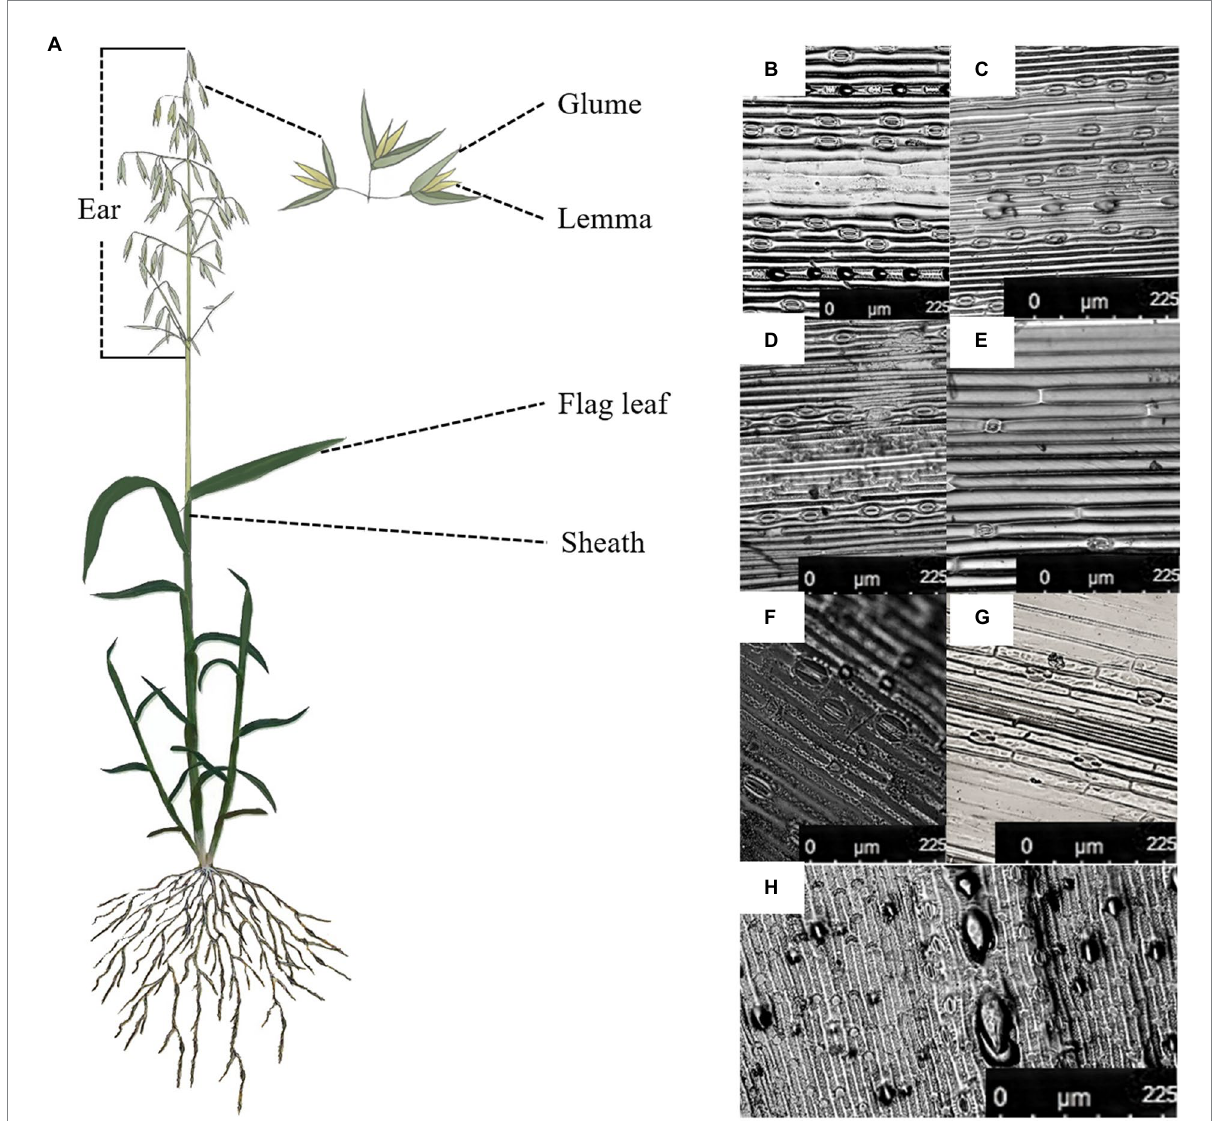
FIGURE 1 Stoma distribution in different green organs of oat on 7DAA. (A) , The flag leaf and the non-leaf organs in the oat plant, (B) , the adaxial surface of the flag leaf, (C) , the abaxial surface of the flag leaf, (D) , the exterior surface of the sheath, (E) , the interior surface of the sheath, (F) , the exterior surface of the glume, (G) , the interior surface of the glume, (H) , the exterior surface of the lemma.